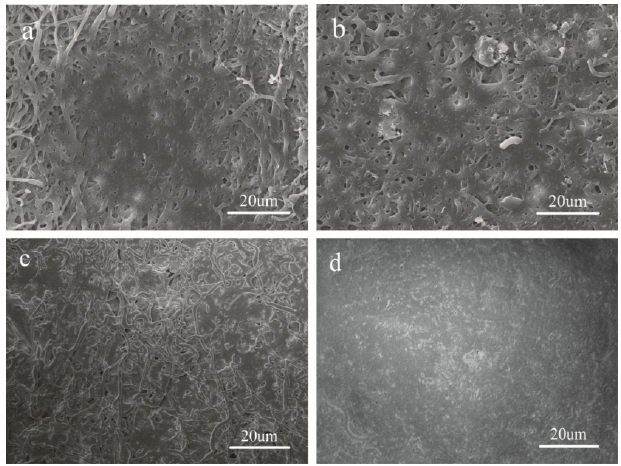
Figure 6. SEM of HUVECs cultured on electrospun nanofibrous scaffolds: ( a ) PLGA; ( b ) P(LA- co -GA- co -MMD) 1 ; ( c ) P(LA- co -GA- co -MMD) 2 ; and ( d ) P(LA- co -GA- co -MMD) 3 .